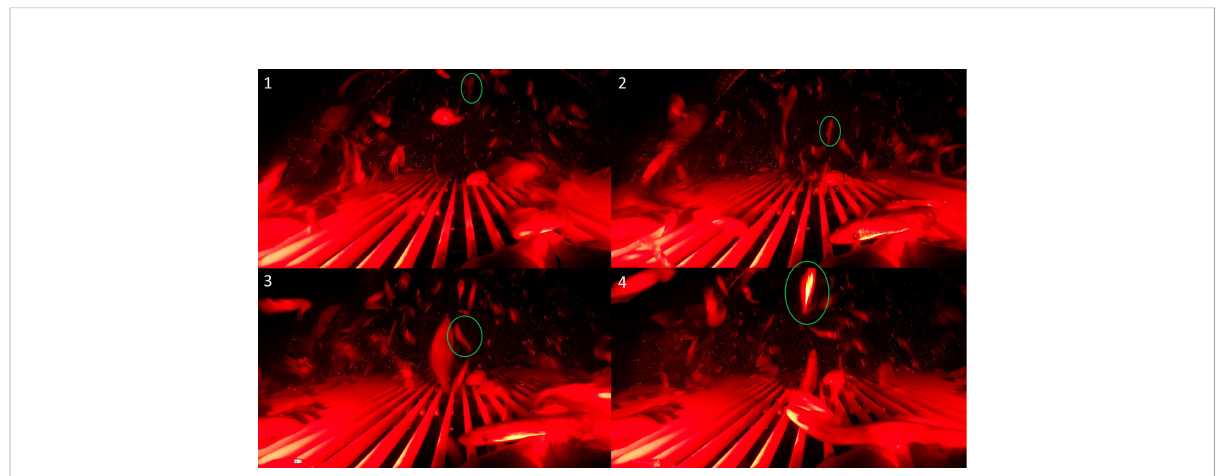
FIGURE 5 A behavioral sequence leading to escapement. Underwater video screenshot of a red fi sh that exhibited away body orientation (1), upwards approach (2), upwards grid reaction (3), and escaped the grid system